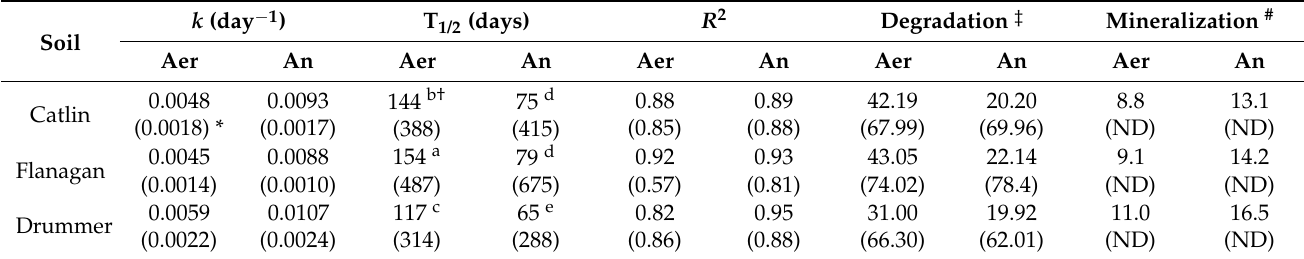
Table 4. Degradation (first-order kinetics) and mineralization of 14 C-metolachlor in different soil types under aerobic (Aer) and anaerobic (An) environmental conditions.